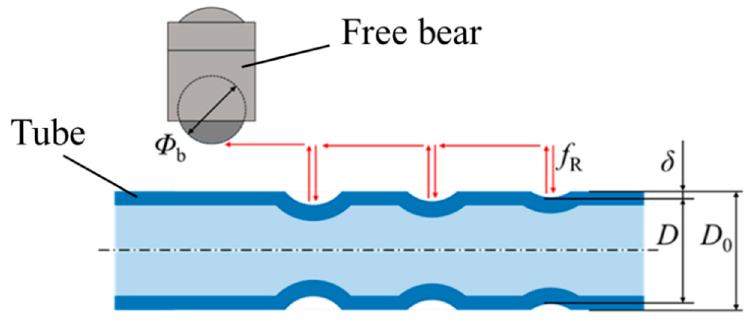
Figure 11. Schematic diagram of the experimental machine.